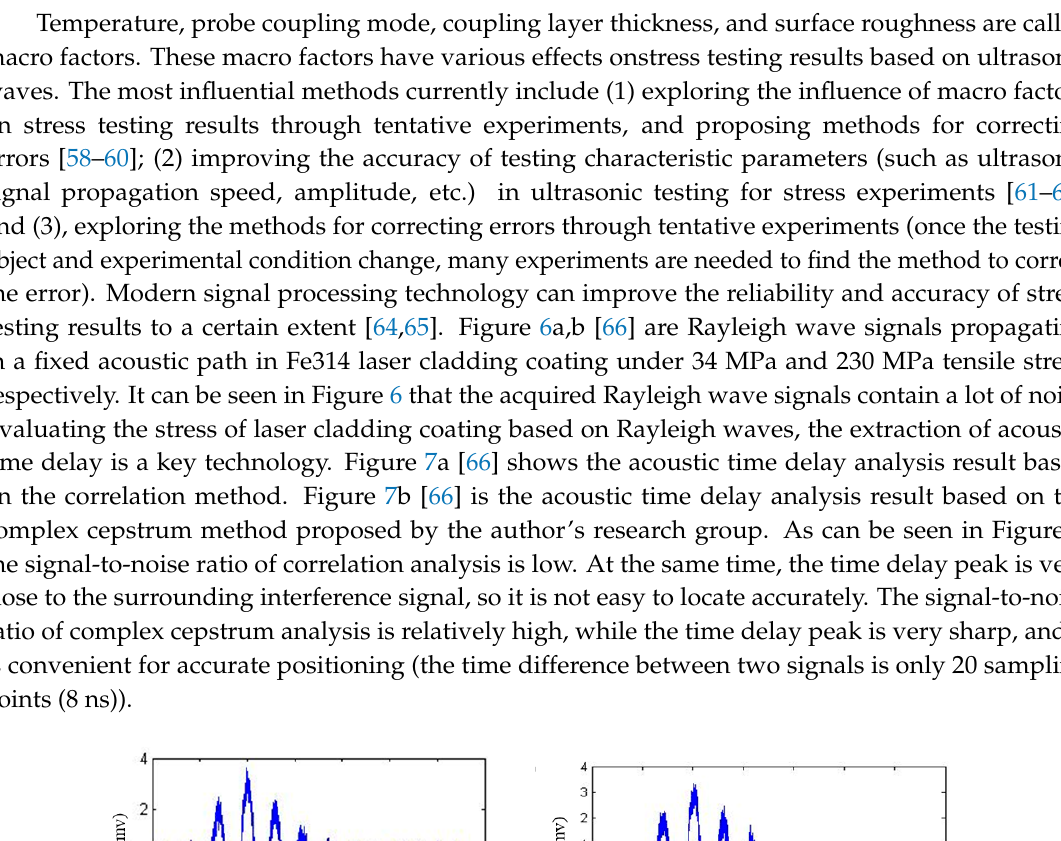
Figure 5. Stress testing results of Fe314 laser cladding coating [51]. “Reproduced with permission from published by © Springer.” (2015).